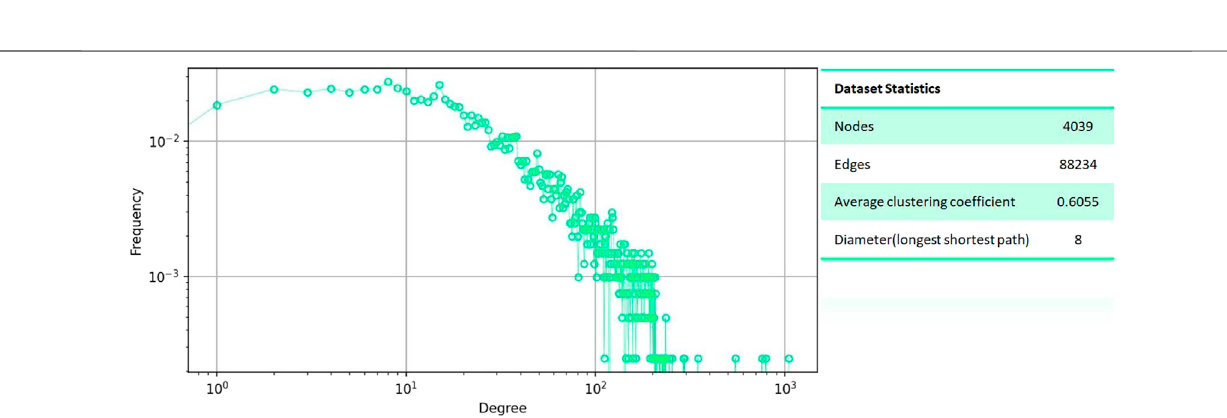
Frontiers in Physics |